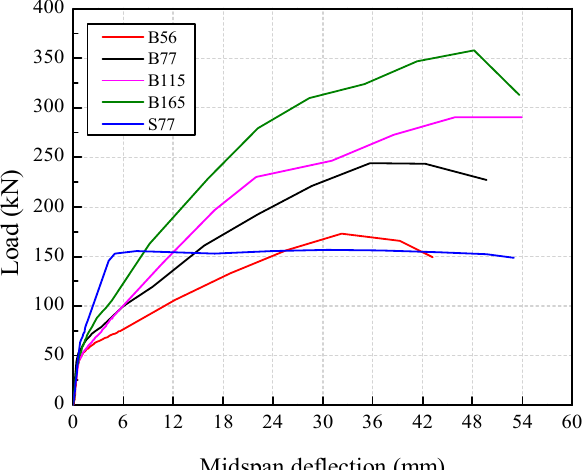
Figure 11. Skeleton curves.